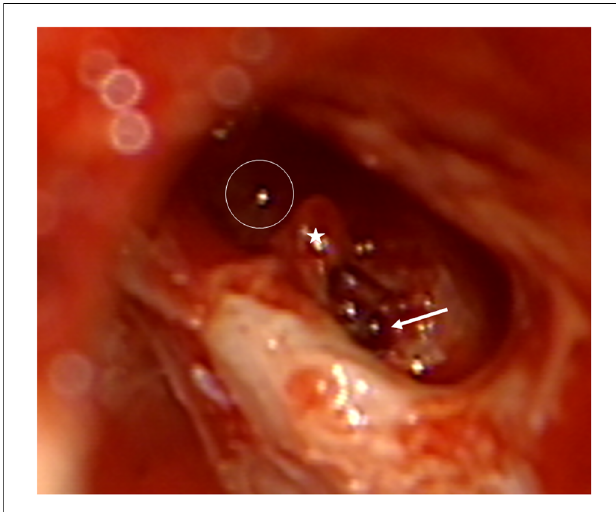
FIGURE 1 Access to the second turn in the right temporal bone. Arrow: basal turn cochleostomy, star: stapes, circle: second turn access.